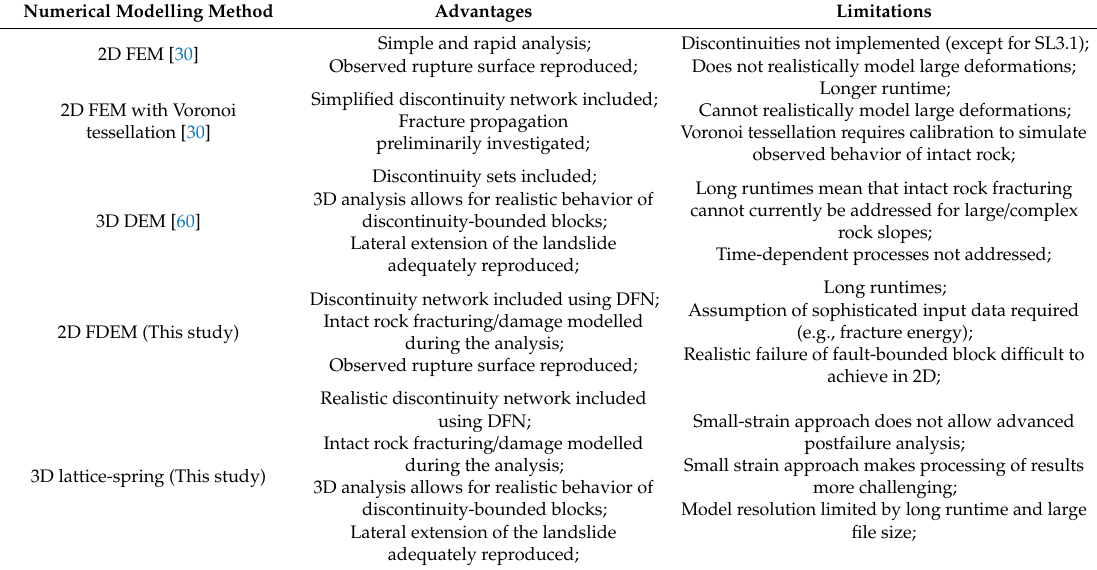
Table 7. Summary of the numerical modelling techniques employed to investigate the 2014 San Leo